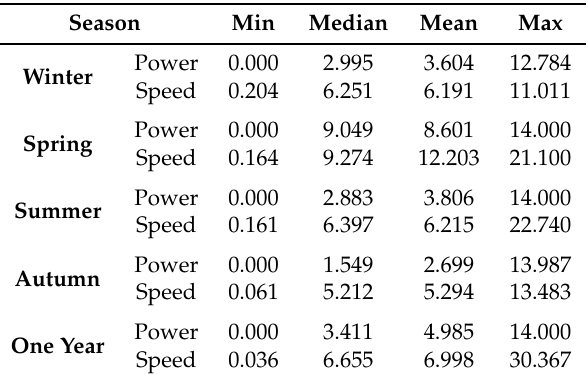
Table 3. Statistical characteristics of